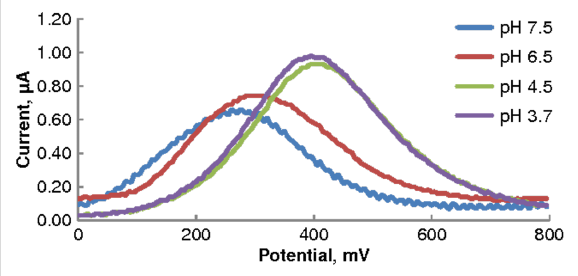
Figure 3: SWV on MWCNT–GCE, 0.25 mmol/L AA in different pH media (phosphate buffer, pH 6.5 and 7.5; acetate buffer, pH 3.7 and 4.5); scan rate = 75